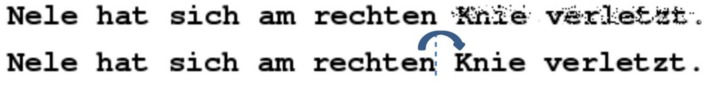
Illustration of our salience manipulation of the parafoveal preview of the target words. The upper panel shows a sentence with the medium salience level of the preview. The lower panel illustrates the location of the invisible boundary (dashed line) and the undegraded target and post-target words which appeared after crossing the boundary.